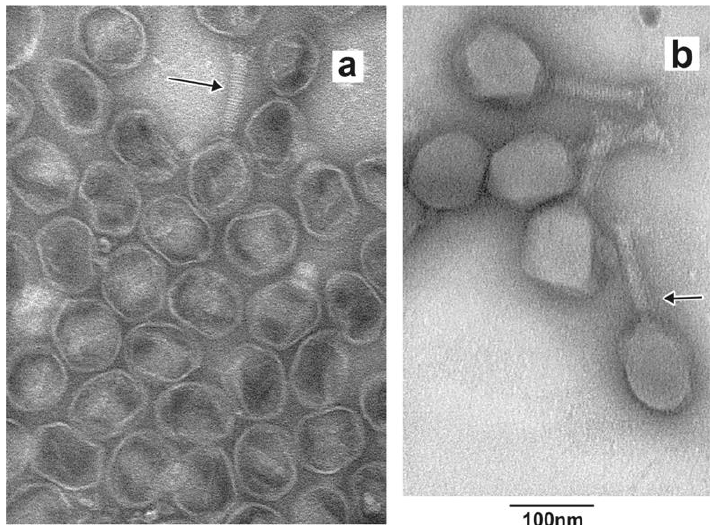
Figure 3. Transmission electron microscopy of negatively stained, unloaded particles that form ( a ) the C band and ( b ) the φ band after rate zonal centrifugation in a sucrose gradient. The arrow in ( a ) indicates a rare capsid with a tail. The arrow in ( b ) indicates a retracted tail fiber next to a tail. As expected, electron microscopy revealed that particles that formed the φ band were primarily phage T4 with elongated capsid (90 ± 5 nm wide; 115 ± 5 nm long) and 100 nm long tail (Figure 3b), within error, the same as previously observed [24,34,35]. The tail fibers were adjacent to and aligned with the tail (arrow in Figure 3b), i.e., in the retracted conformation previously described [36,37]. Occasional DNA-filled, phage-like capsids without tails were also